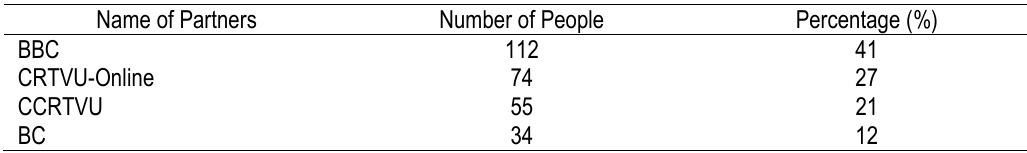
Table 4. Brand Recognition Survey Online (275 people were